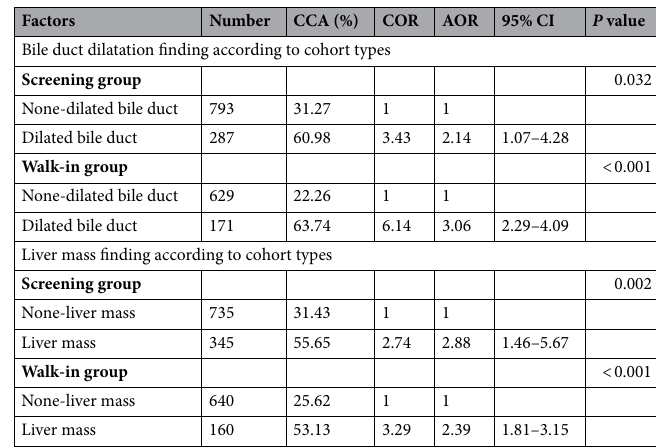
Table 4. Interaction between cohort types and history of ultrasonography findings with cholangiocarcinoma association using multiple logistic regression. CCA cholangiocarcinoma, COR crude odds ratio, AOR adjusted odds ratio, 95% CI—95% confidence interval of adjusted odds ratio; P value, probability values from likelihood-ratio chi-square tests.